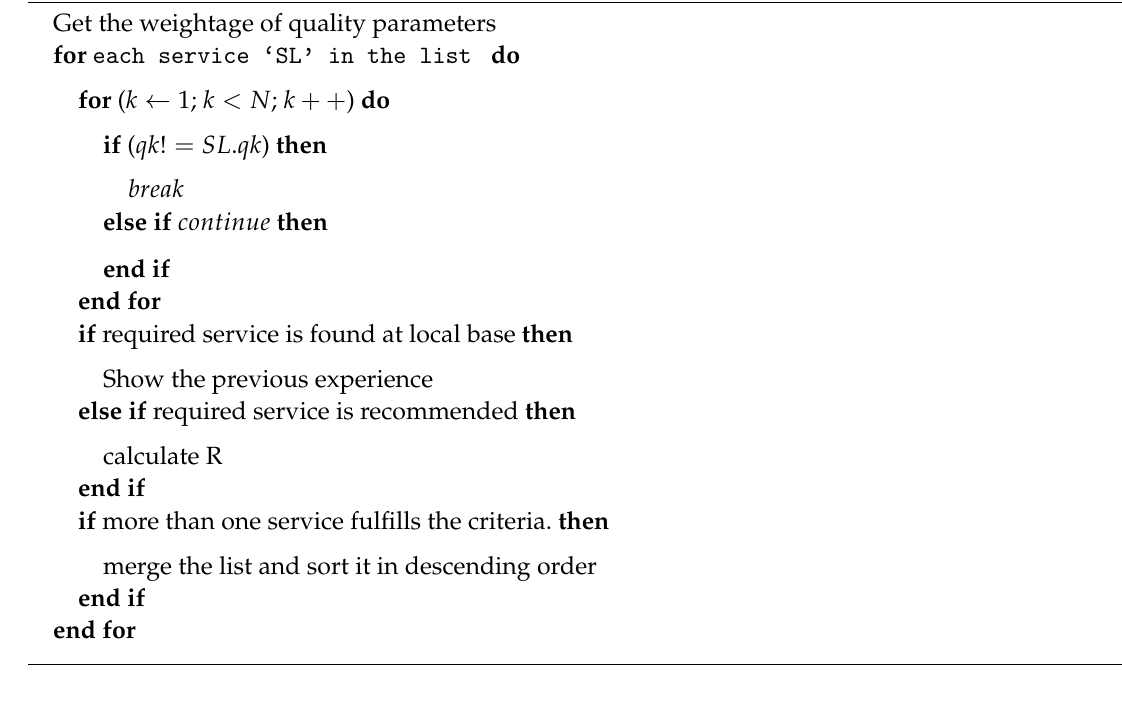
Algorithm 2 Services identification based on